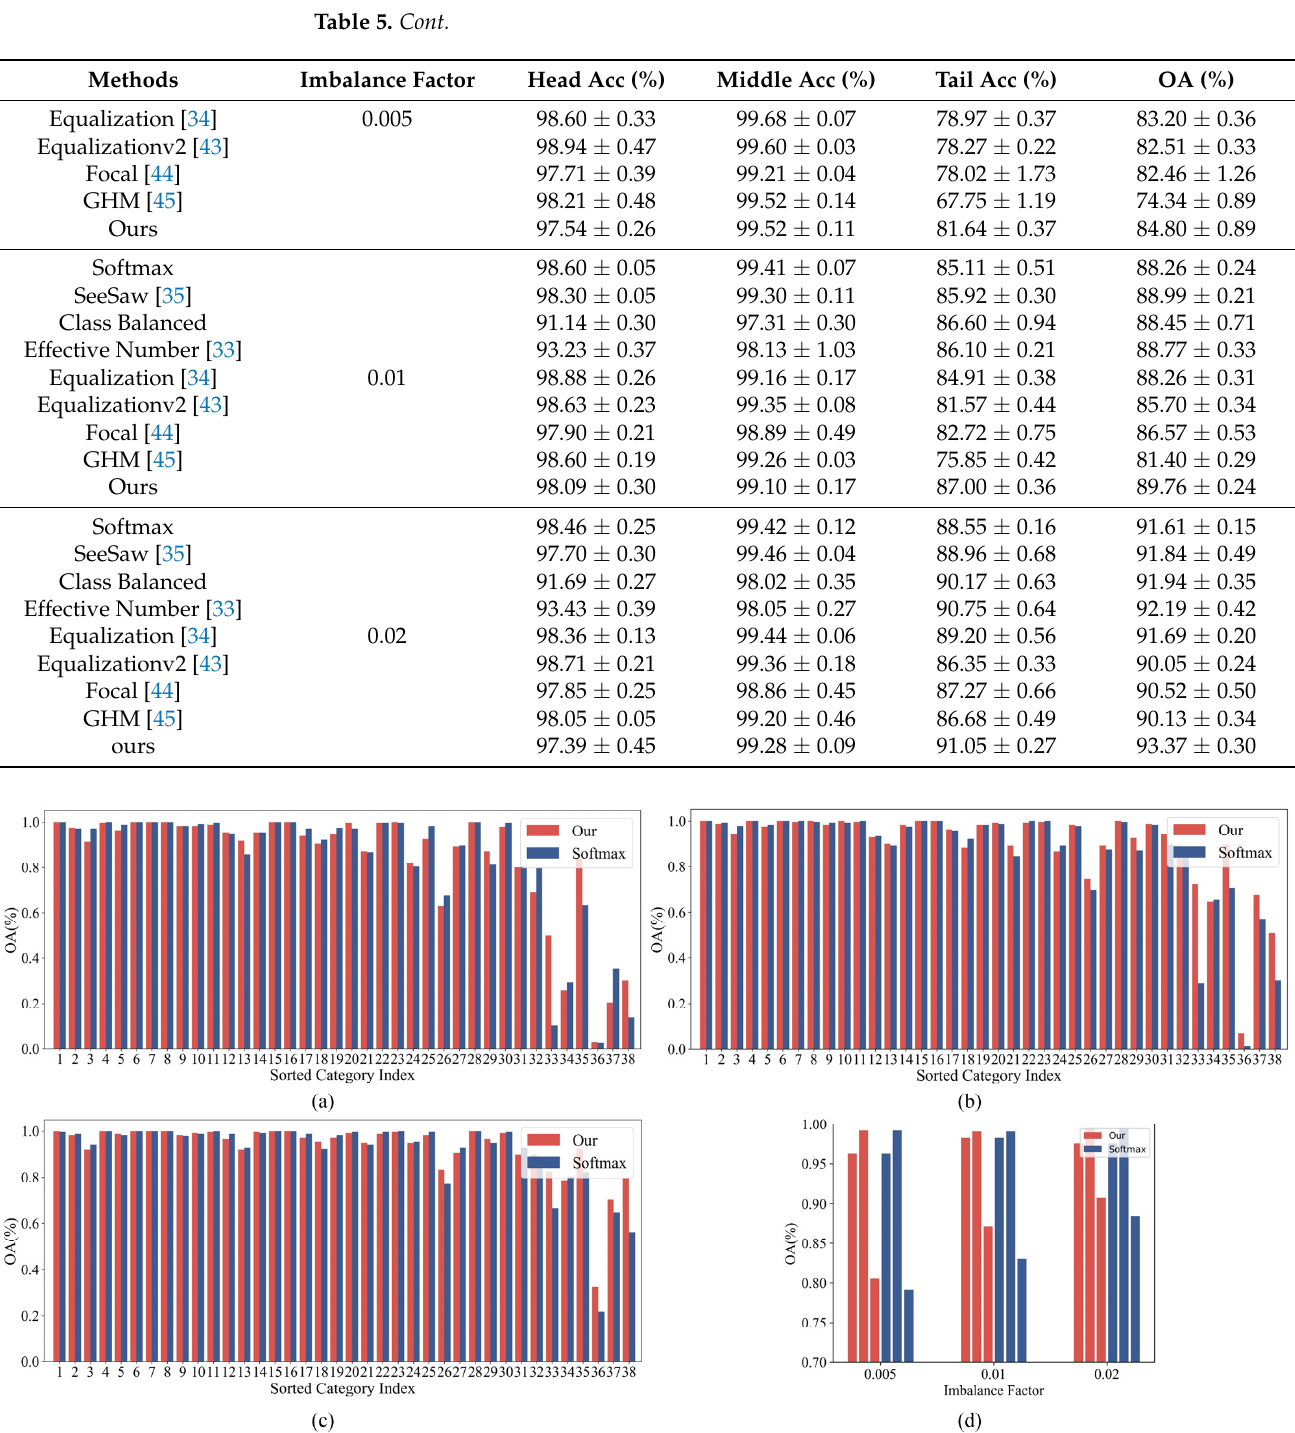
Figure 9. ( a – c ) show the classification accuracy of the proposed method and Softmax cross-entropy method for samples from each category in the long-tailed PatternNet dataset with imbalance ratios of 0.005, 0.01, and 0.02, respectively. ( d ) shows the average classification accuracy of the proposed method and the Softmax cross-entropy method on the long-tailed PatternNet dataset with imbalance ratios of 0.005, 0.01, and 0.02 for samples from the head categories, middle categories and tail categories, respectively.